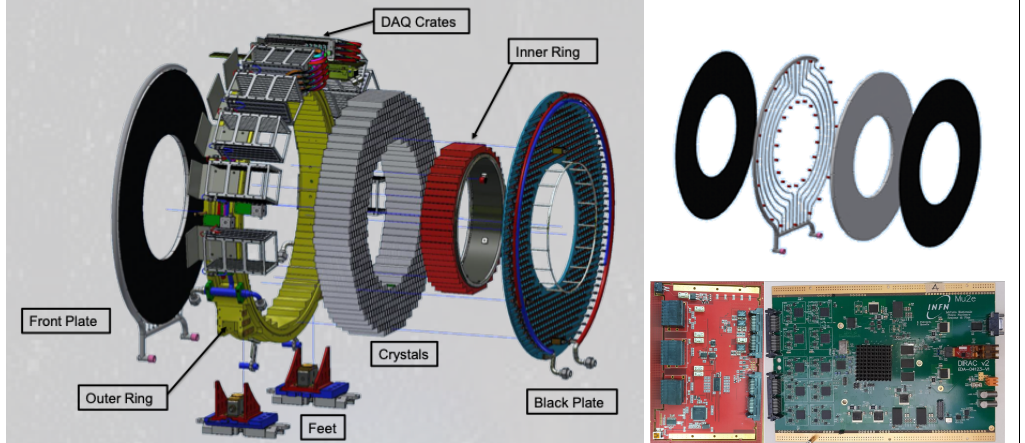
Figure 3. ( Left ) breakout of calorimeter mechanical components; ( top right ), breakdown of front panel plate embedding source tubing; and ( bottom right ), the mezzanine and DIRAC boards. Each disk is filled with a matrix of 674 parallelepiped undoped CsI crystals (34 × 34 × 200 mm 3 ) for an inner/outer diameter of 650 mm/1314 mm. The crystals are wrapped in 150 µ m thick Tyvek foils and separated from each other with 50 µ m thick Tedlar